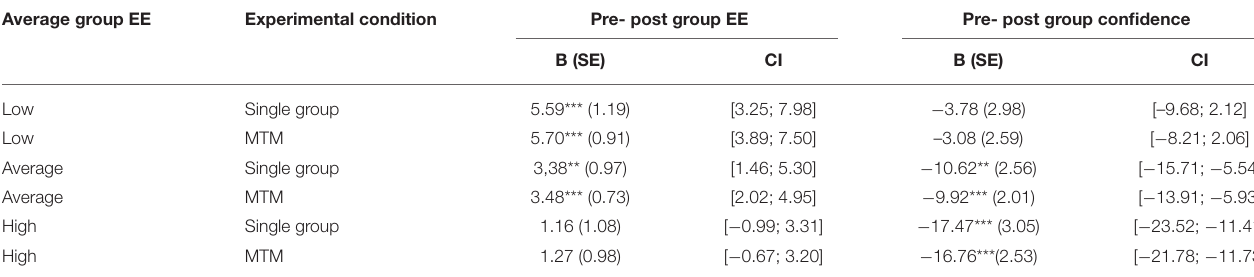
TABLE 3 | Conditional effects.